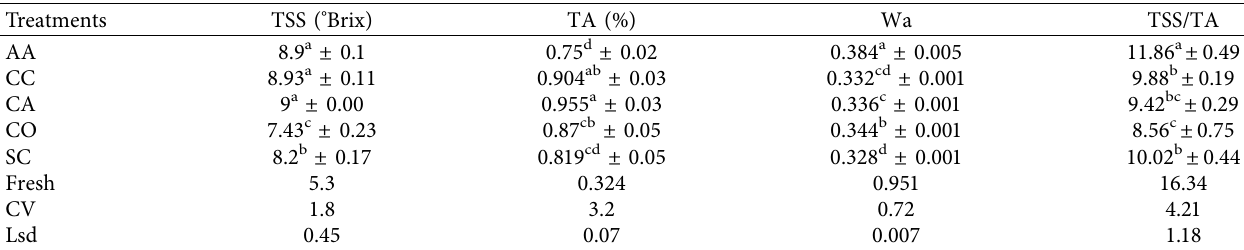
Table 2: Effect of predrying treatment on TSS, TA, Wa, and TSS/TA of twin-layer-solar-tunnel-dried tomato samples.